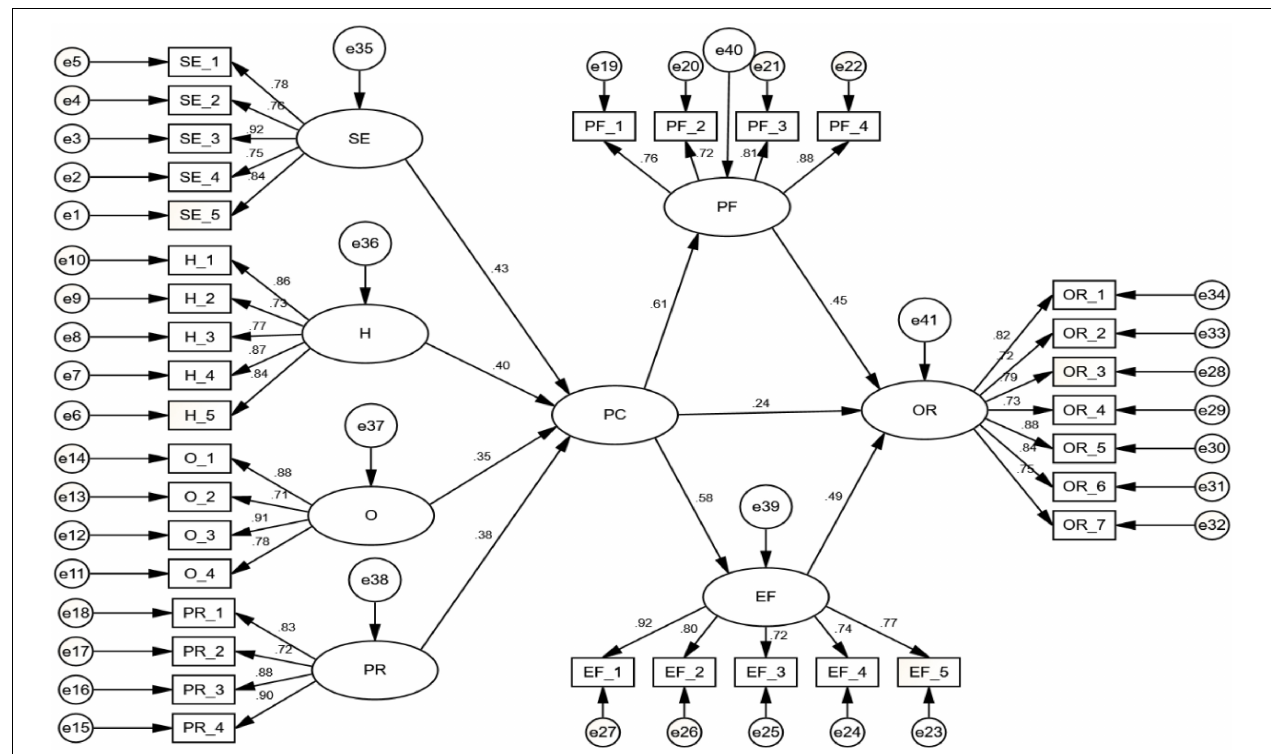
FIGURE 3 | Structural model.